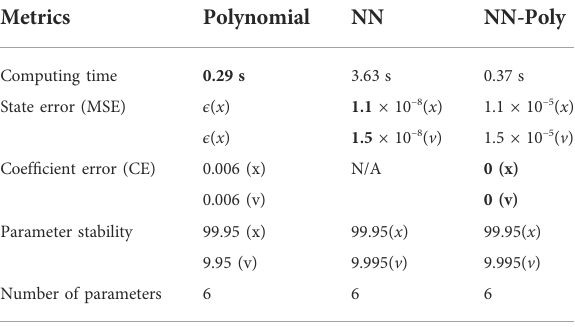
TABLE 3 1DOF spring evaluation of performance for all system identi fi cation methods.